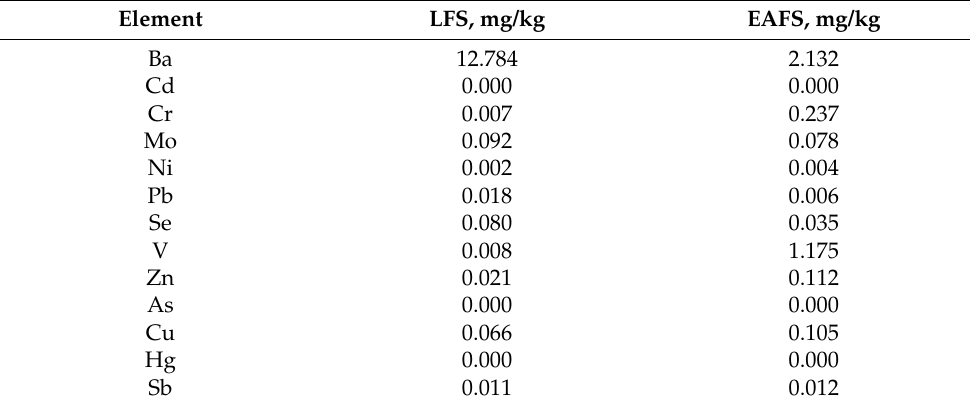
Table 10. Concentration of chemical elements in the leaching of ladle furnace slag and electric arc furnace slag.